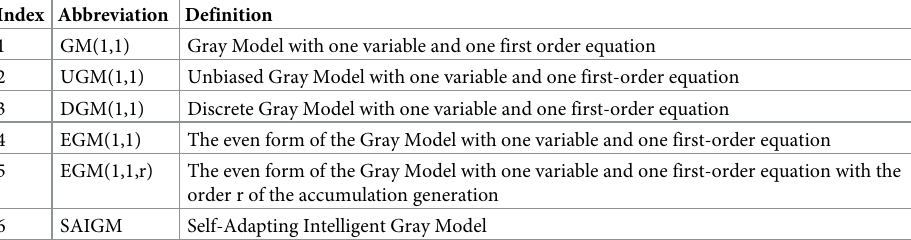
Table 1. Abbreviations and corresponding definitions for different gray prediction